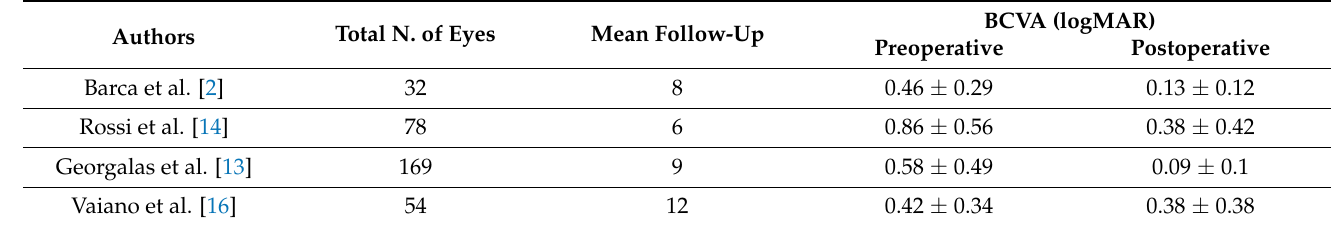
Table 1. Weighted mean preoperative and postoperative best-corrected visual acuity by Carlevale lens